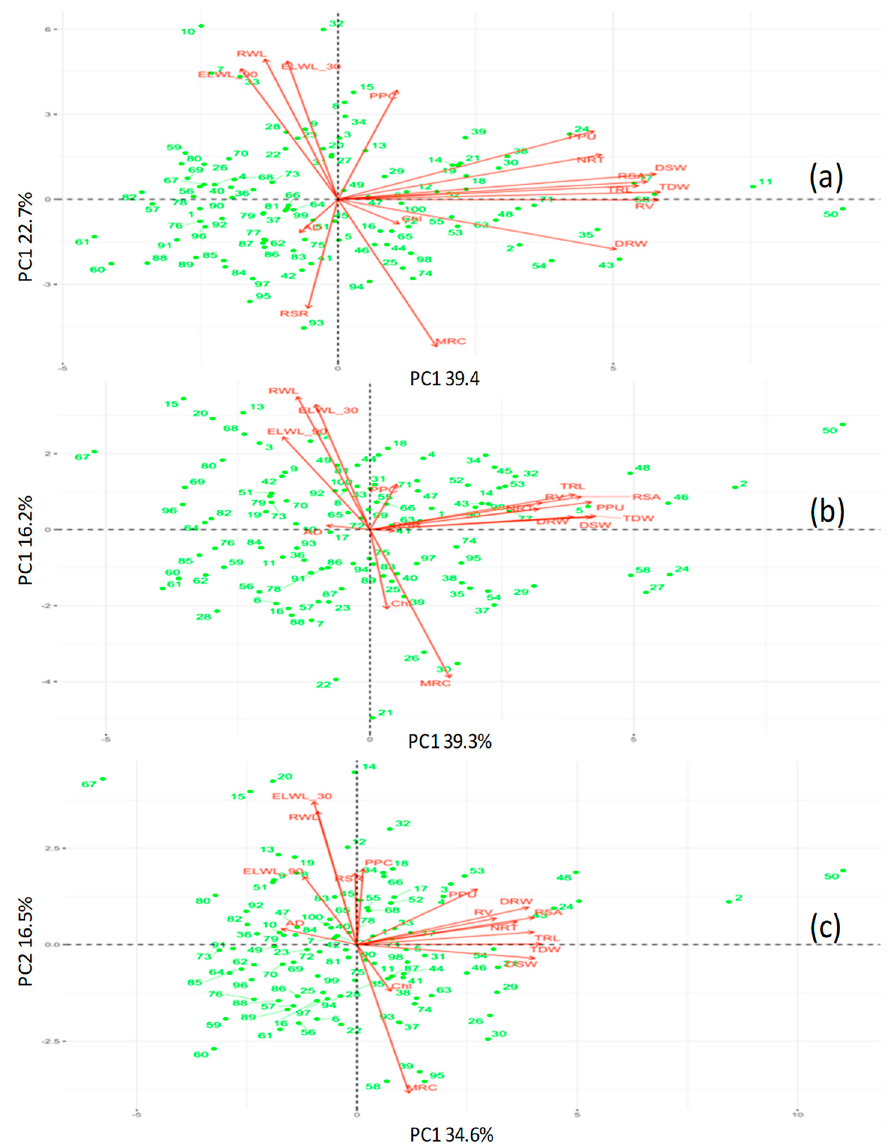
Figure 1. Biplot using relative values of 16 physiological traits of mungbean accessions grown hydroponically under ( a ) low phosphorus, ( b ) drought, and ( c ) combined stress. Arrow represents agro-physiological traits, its length corresponds to the contribution of each trait. Number represents 100 mung bean accessions corresponding to Supplementary Table S1. Abbreviation: ELWL_30 and ELWL_90, excised leaf water loss per unit initial water content after 30 min and 90 min; RWL, rate of water loss; MRC, moisture retention capacity; PPC, plant P concentration; PPU, plant P uptake; Chl, chlorophyll concentration; DSW, dry shoot weight; DRW, dry root weight; TDW, total dry weight; RSR, root-to-shoot ratio; TRL, total root length; RSA, root surface area; AD, average root diameter; RV, root volume; NRT, number of root